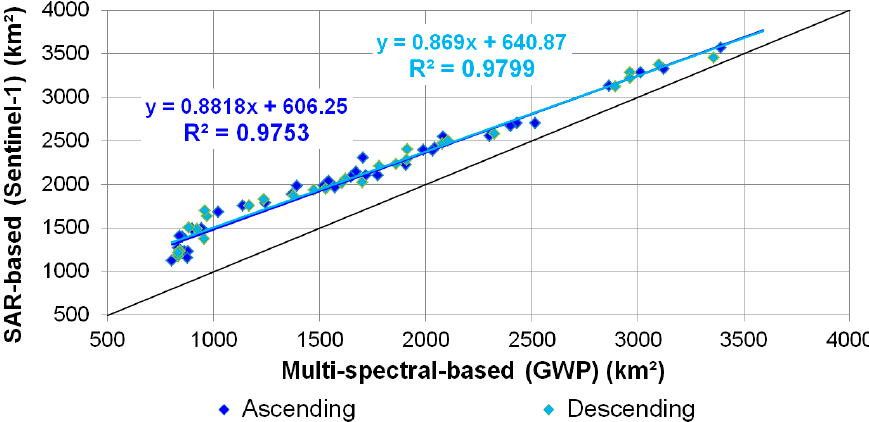
Figure 5. The internal cross-comparison of Lake Urmia’s surface area detected by ascending and descending imagery of Sentinel-1, and the external comparison with the GWP product.